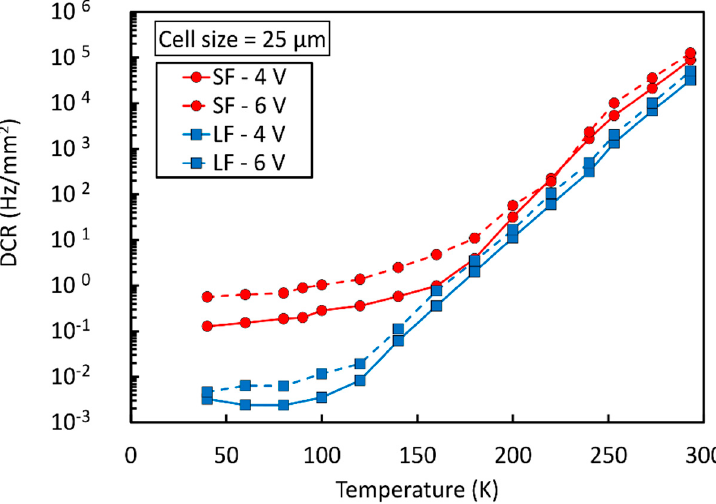
Figure 16. DCR as a function of temperature for the NUV-HD (SF) and NUV-HD-LF (LF) technologies at two values of OV. Measures taken from Reference [36]. SF: Standard field, LF: Low field.